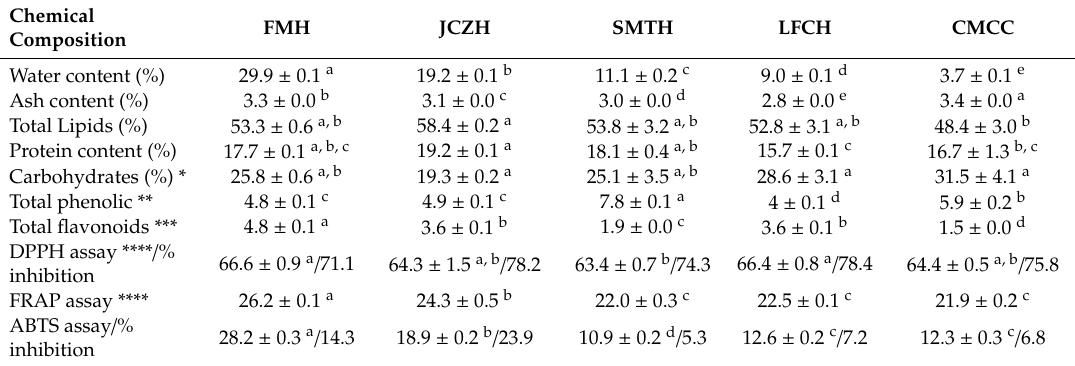
Table 2. Chemical composition, total phenolics, total flavonoids, and antioxidant activity from five population of P. cembroides seeds. The descriptive statistics are presented in terms of the mean ± SD (n = 3). Mean values with the same letters indicate homogeneous subsets for p ≤ 0.05 according to Duncan